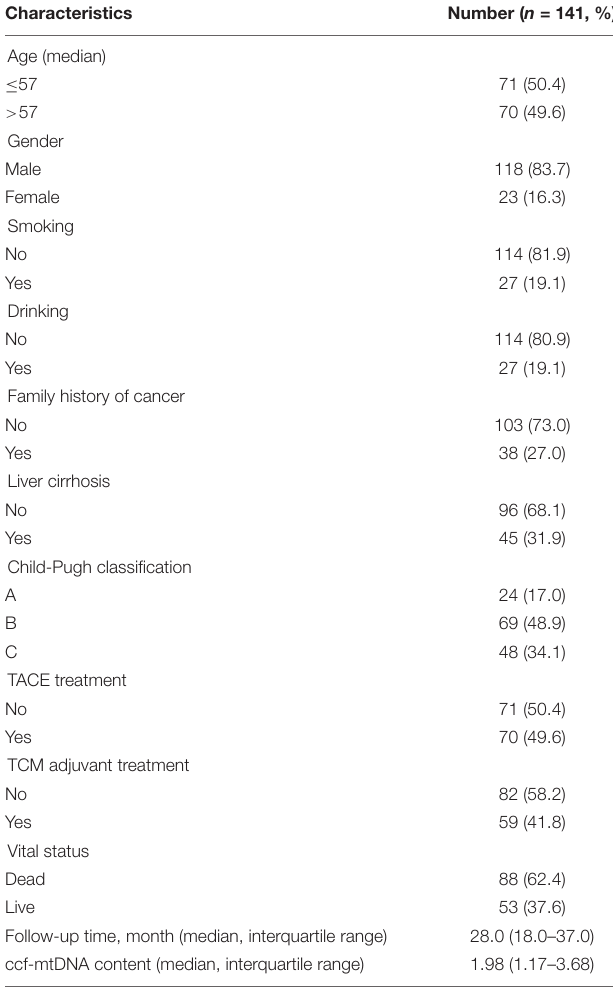
TABLE 1 | Characteristics of the study